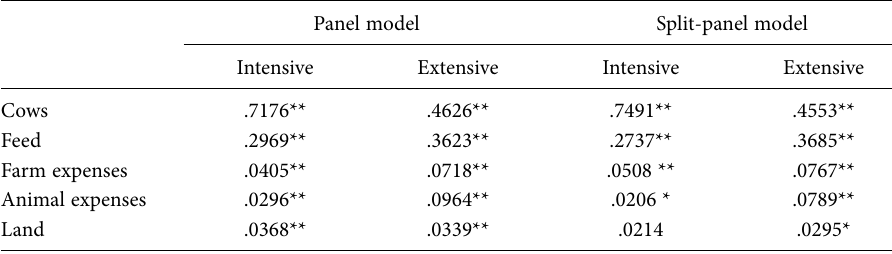
Table 4. Output elasticities evaluated at the geometric mean of the